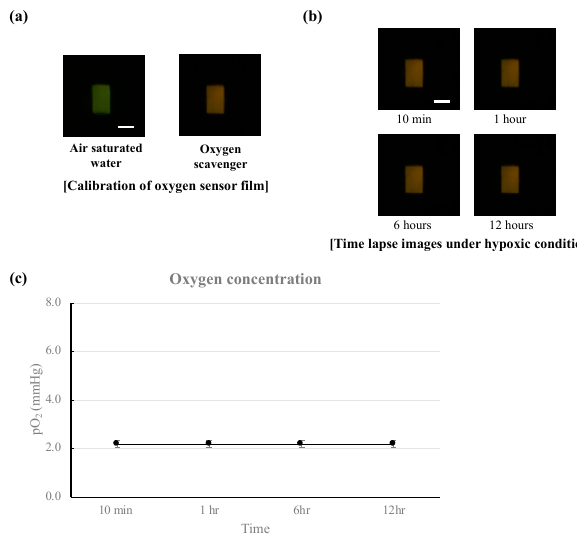
Figure 5. Validation of long-term hypoxia formation in the microfluidic device using oxygen sensor film and detector. ( a ) Calibration for oxygen detector; ( b ) time-lapse images of oxygen sensor film under hypoxic condition; ( c ) oxygen concentration measured with the time-lapse images.